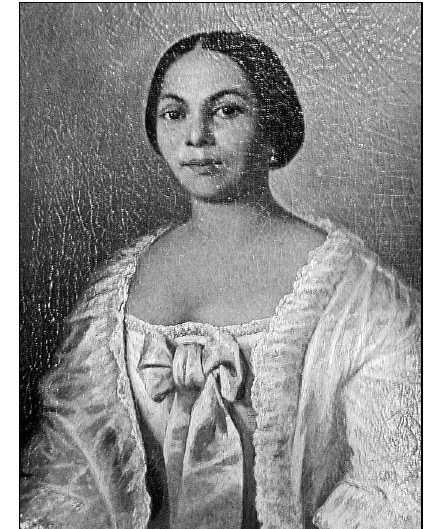
Figure 2 An early nineteenth-century portrait of a grand-daughter of Marie Thérèze